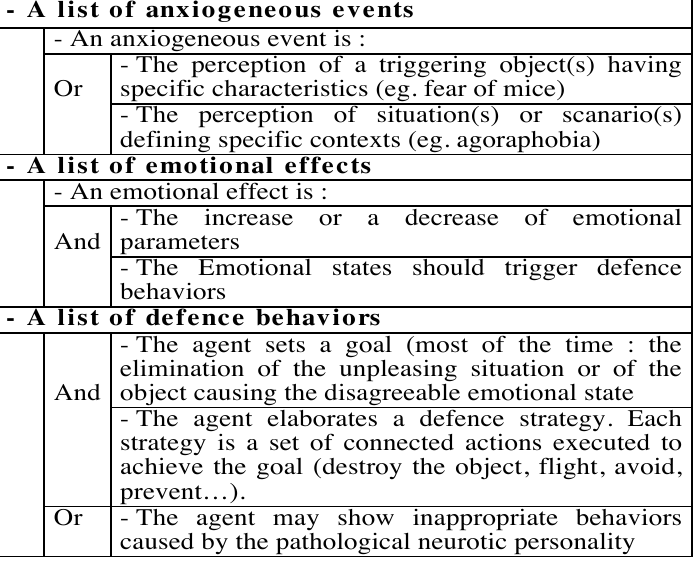
Table 1 Couples of (positive/negative) emotion variables according to the OCC model